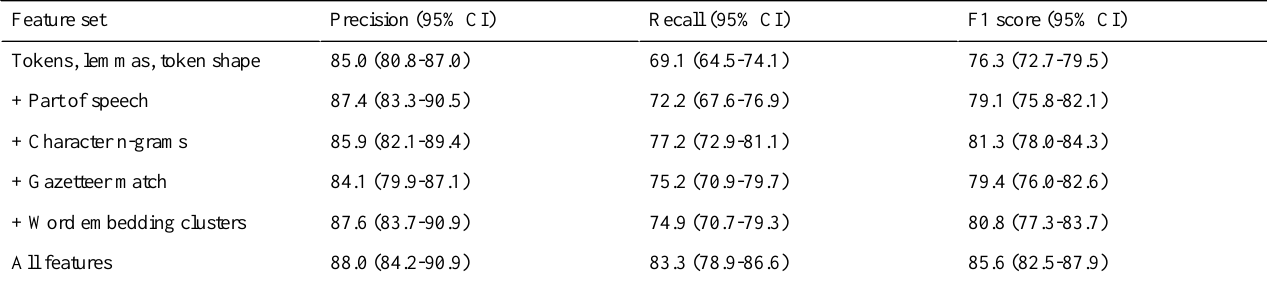
Table 5. Ablation results of model features.